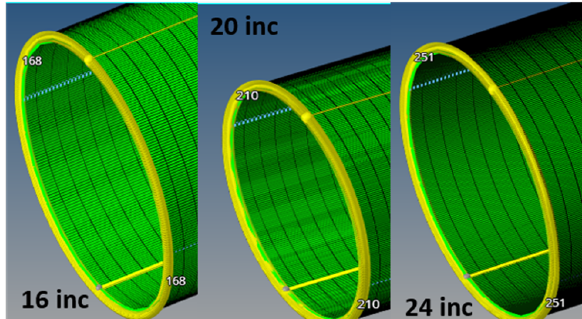
Figure 3: The number of nodes in each pipe diameter variation models.